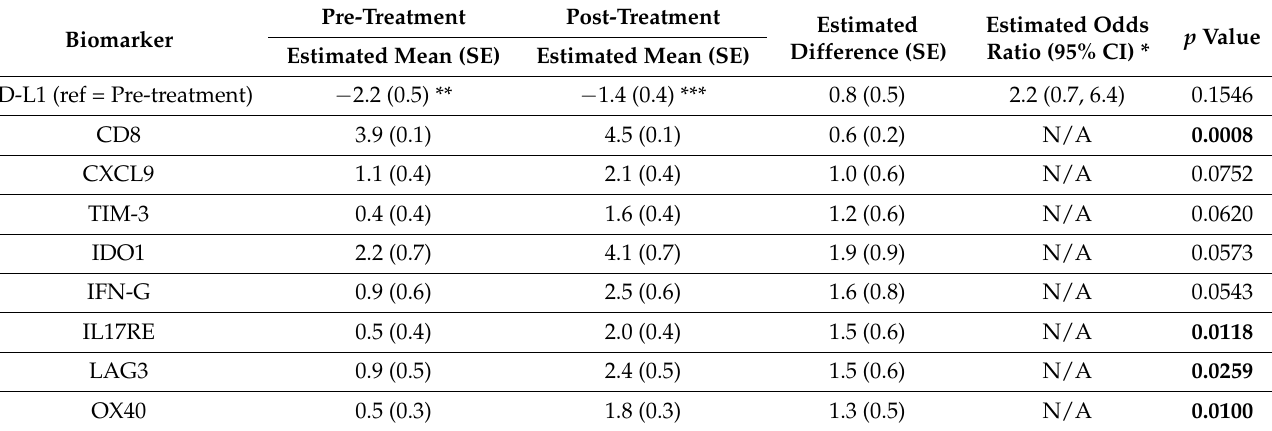
Table 2. Univariate analyses for change in